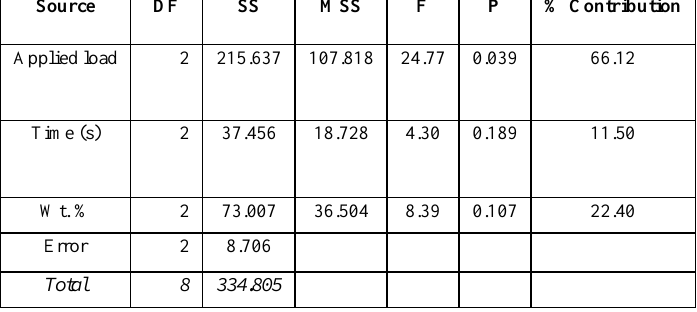
Table 9: Analysis variance results for high